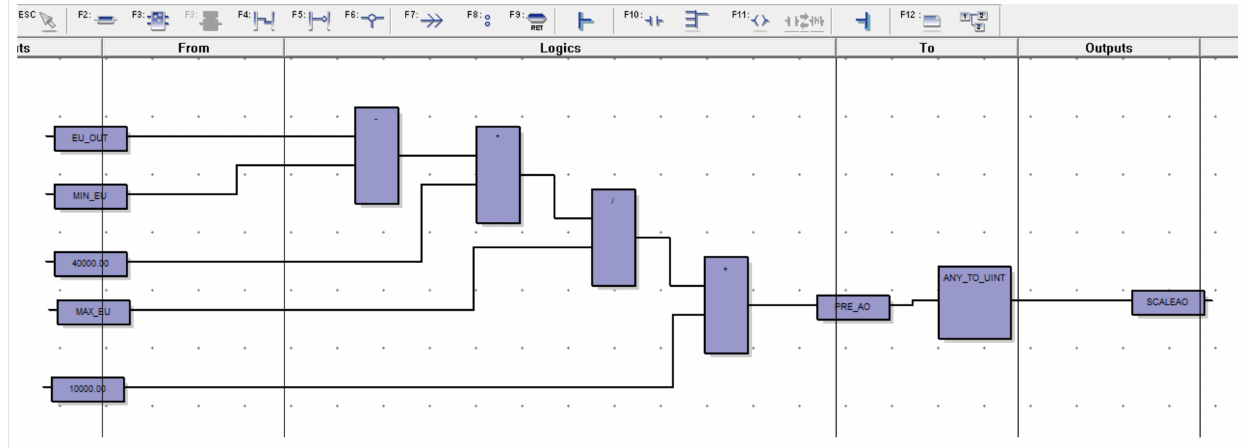
Figure 8. Logic of analog output